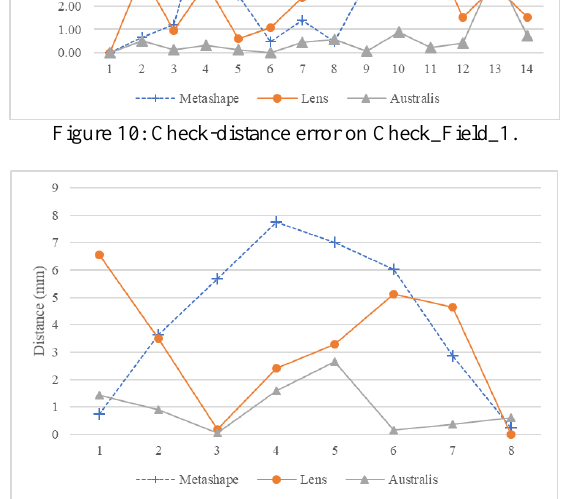
Figure 11: Check-distance error on Check_Field_2.